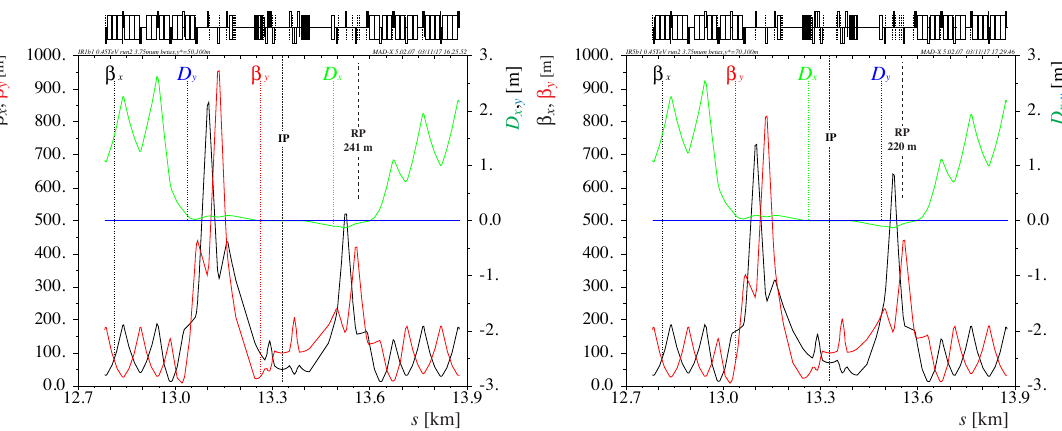
Figure 2. 50/100m ( left ) and 70/100m ( right ) optics, first successfully tested in the LHC on 26 October 2017. = 100 m and a phase advance of 90 ◦ between IP and the They feature for both experiments β ∗ y = 50 m nominal Roman Pot positions (241 m from IP1, 220 m at IP5) in the vertical plane. A lower β ∗ x = 70 m for IP5 was chosen in the horizontal plane to improve the t for IP1 and β ∗ max acceptance. x The phase advance in the horizontal plane was matched to be close to 180 ◦ (but not exactly 180 ◦ , as important for ALFA). They were successfully commissioned with beam on 26 October 2017. The β functions were measured and corrected (to a β -beating level below 10% [15]). The aperture was